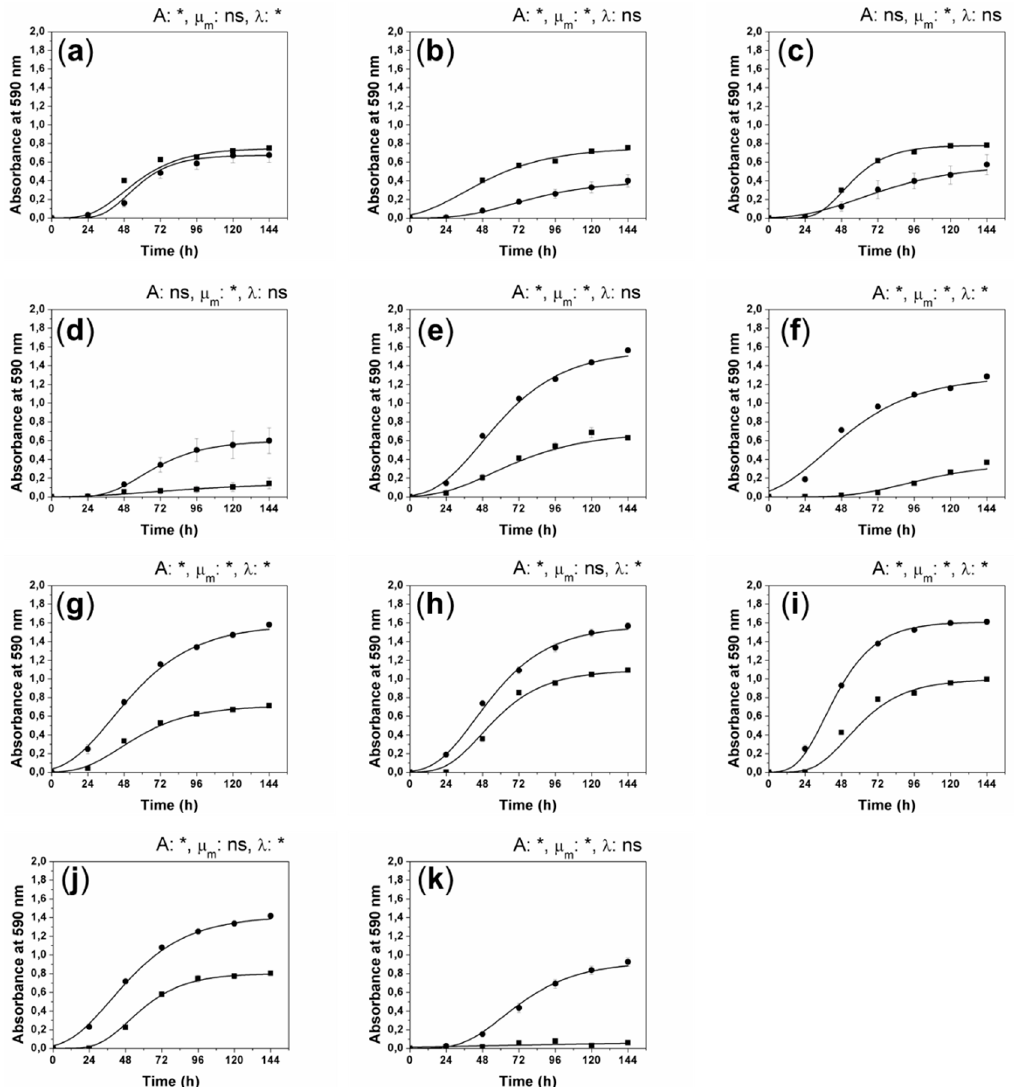
Figure A1. Colour development curves on the EcoPlate (Biolog) plates over time, adjusted according to the modified Gompertz model. λ , latency time (lag phase); µ m , maximum colour development rate; A, maximum absorbance. ( a ) S1M5C01, ( b ) S1M5C14, ( c ) S1M6C01, ( d ) S1M8C10, ( e ) S2M1C03, ( f ) S2M2C03, ( g ) S2M4C03, ( h ) S2M5C01, ( i ) S2M5C03, ( j ) S2M6C01, ( k ) S2M8C12. The nomenclature for each composite sample indicates the site (S1 or S2), then the mycobiont (M1, M2, M4, M5, M6, or M8), then the cyanobiont (C01, C03, C10, C12, or C14) and whether it originates from the lichen thallus (-L) or from the substrate (-S). The significantly-different values ( p ≤ 0.05) for each of the parameters are indicated by an asterisk (*) when comparing the kinetics of the thalli ( ■ ) and the substrates ( ● ).